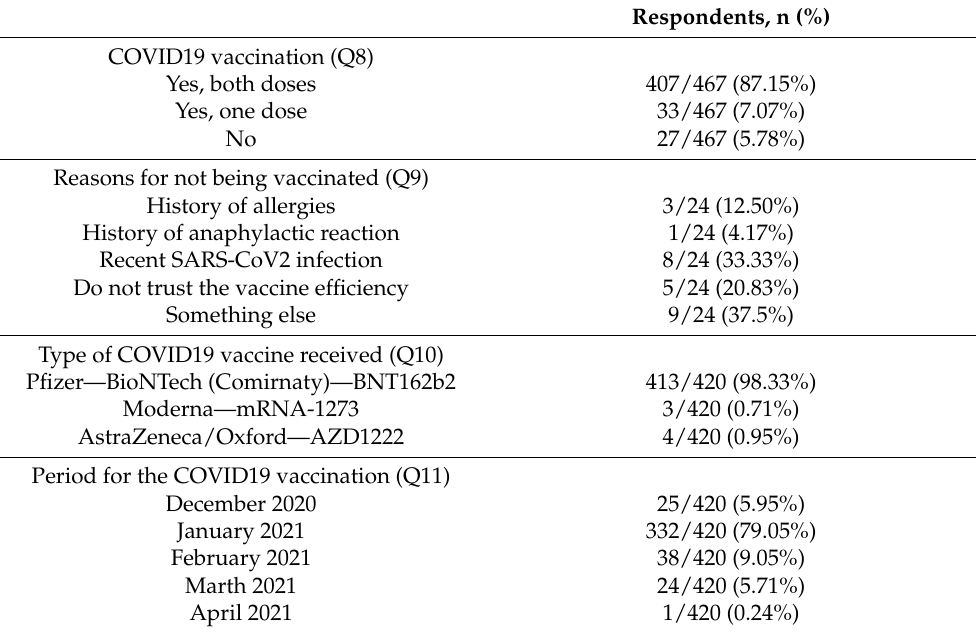
Table 1. General data regarding the physicians’ COVID-19